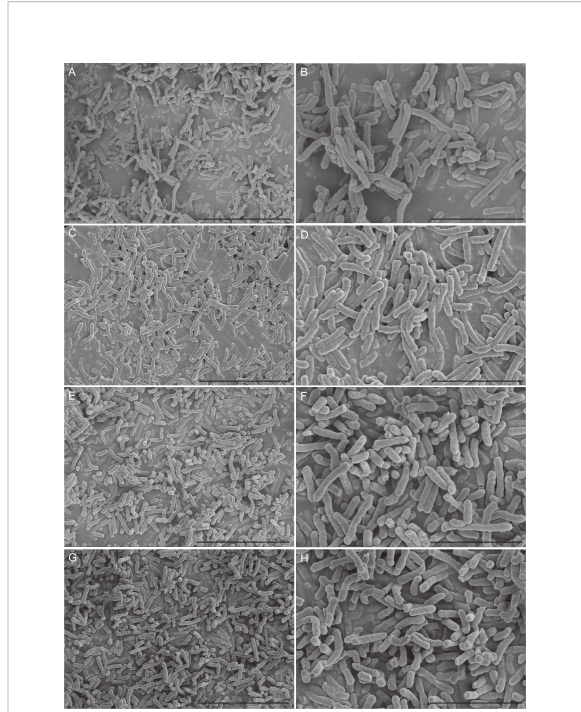
FIGURE 1 Scanning electron microscopy imaging analysis of four